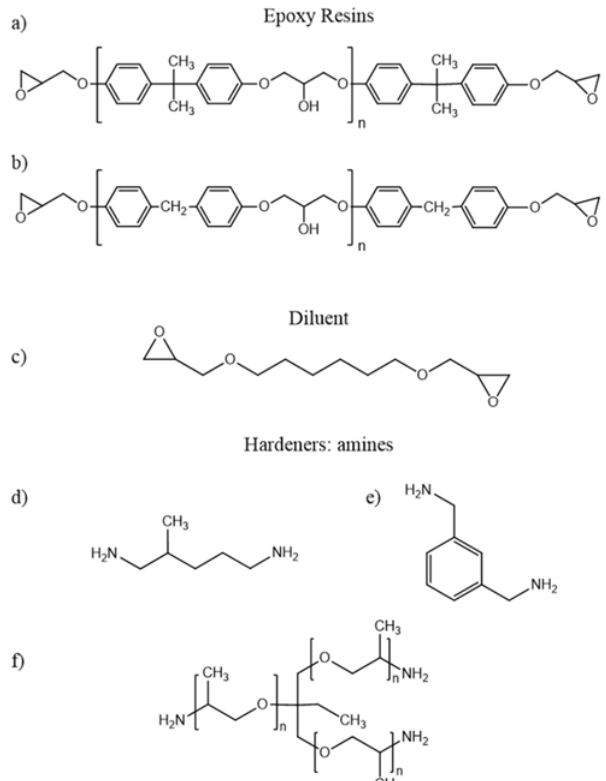
Figure 1: Chemical structures of (a) Bisphenol A epoxy resin (DGEBA), (b) Bisphenol F epoxy resin (DGEBF), (c) 1,6-bis(2,3- epoxypropoxy)hexane, (d) 2-methylpentane-1,5-diamine, (e) m-phenylenebis(methylamine) and (f) trimethylolpropane tris[poly(propylene glycol), amine terminated] ether.